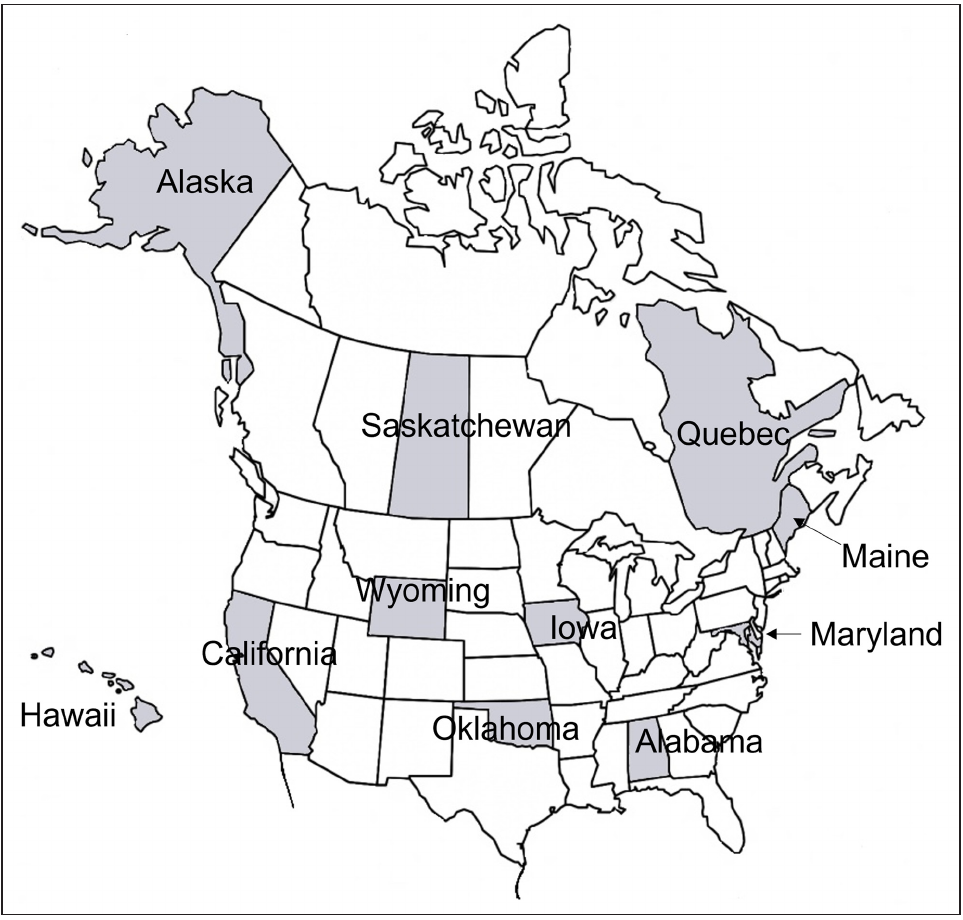
Figure 1 Map of states and provinces used for detailed analyses of number of participants, effort, and number of species